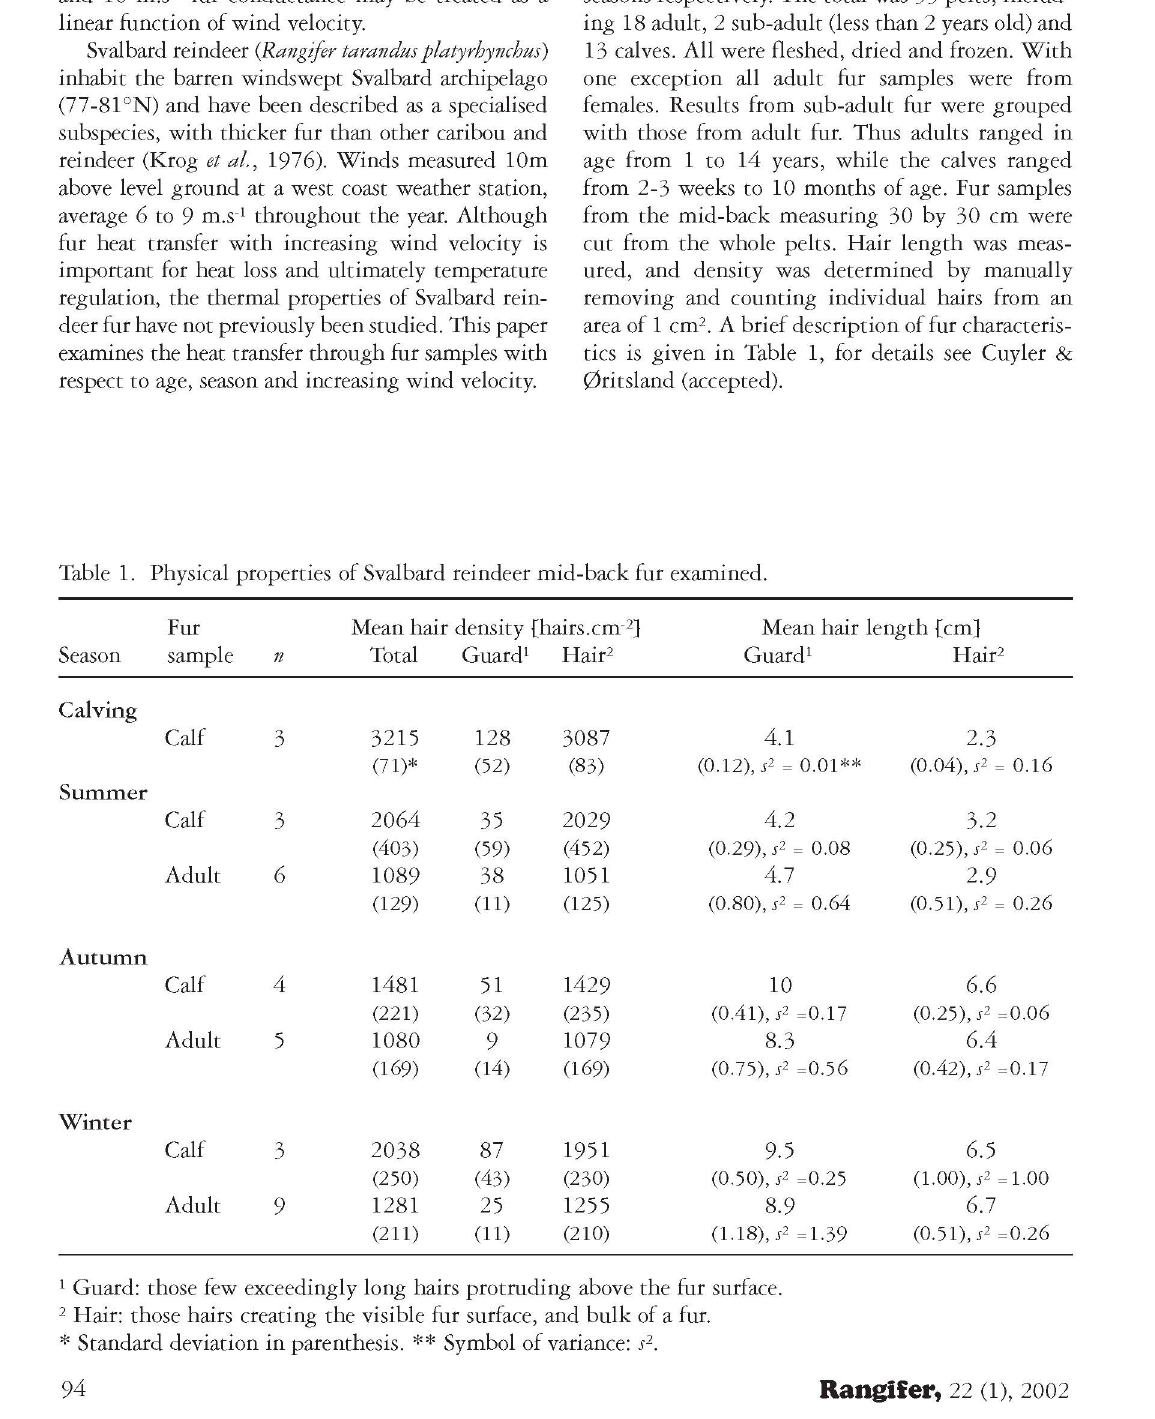
Table 1. Physical properties of Svalbard reindeer mid-back fur examined.